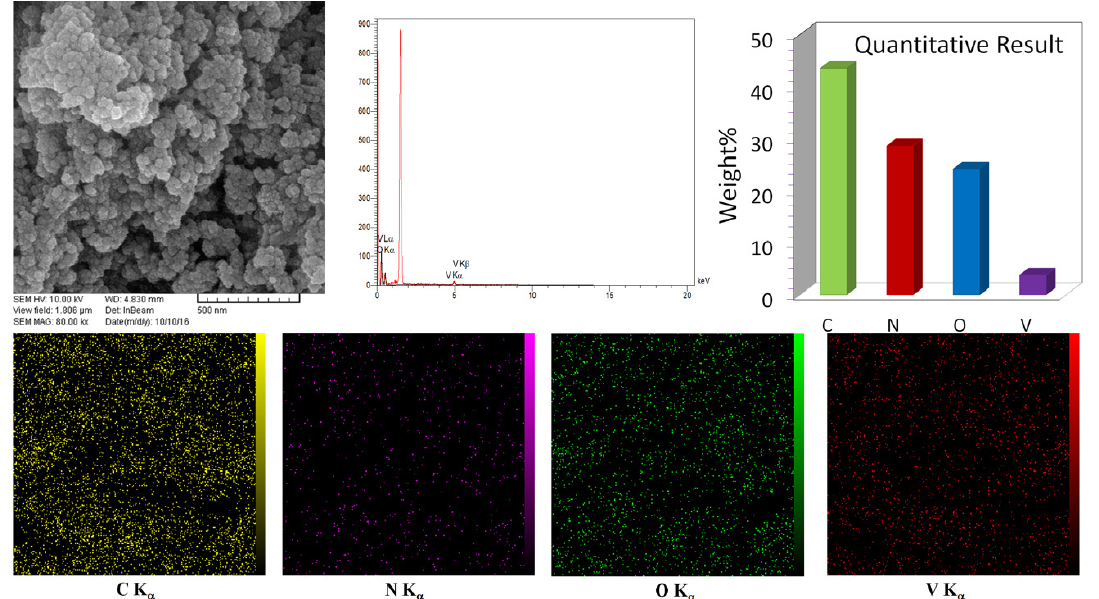
Fig. 9 SEM, EDS, and mapping of nanoscale 1